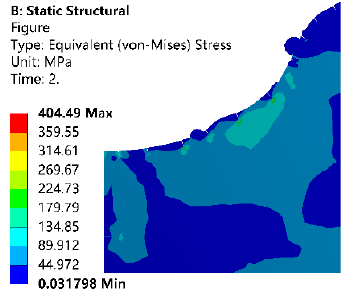
Figure 13. The residual stress after machining.